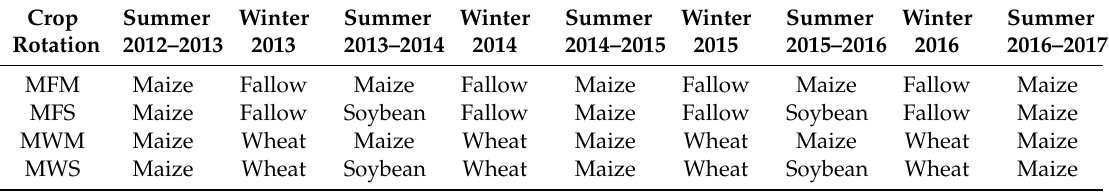
Table 1. Summary of the crop rotations done at the University of Fort Hare (UFH) research farm. Crop